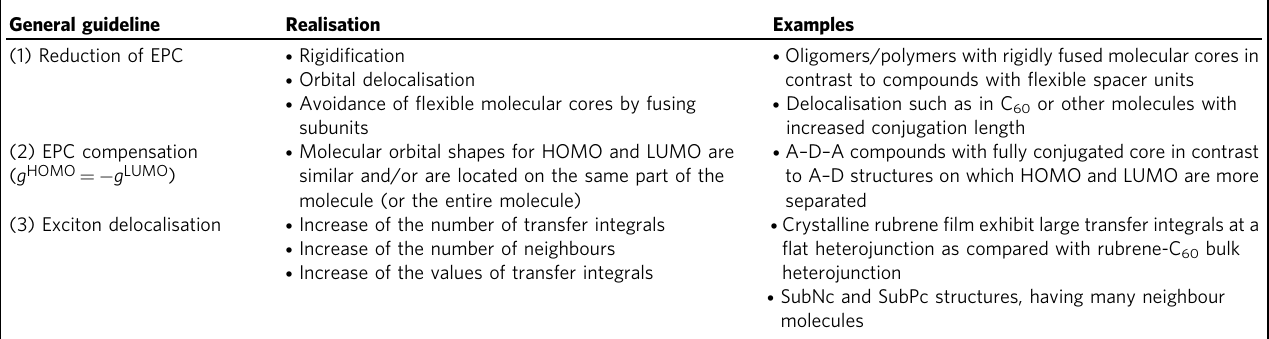
Table 1 Summary of guidelines to reduce vibration-induced radiative voltage